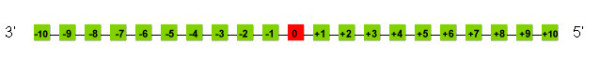
Schematic of flanking regions in 3' and 5' direction. Each position in the NCBI dataset was evaluated with regard to nucleotide identity, and by nucleotide and also purine/pyrimidine identity in the Broad Institute dataset.